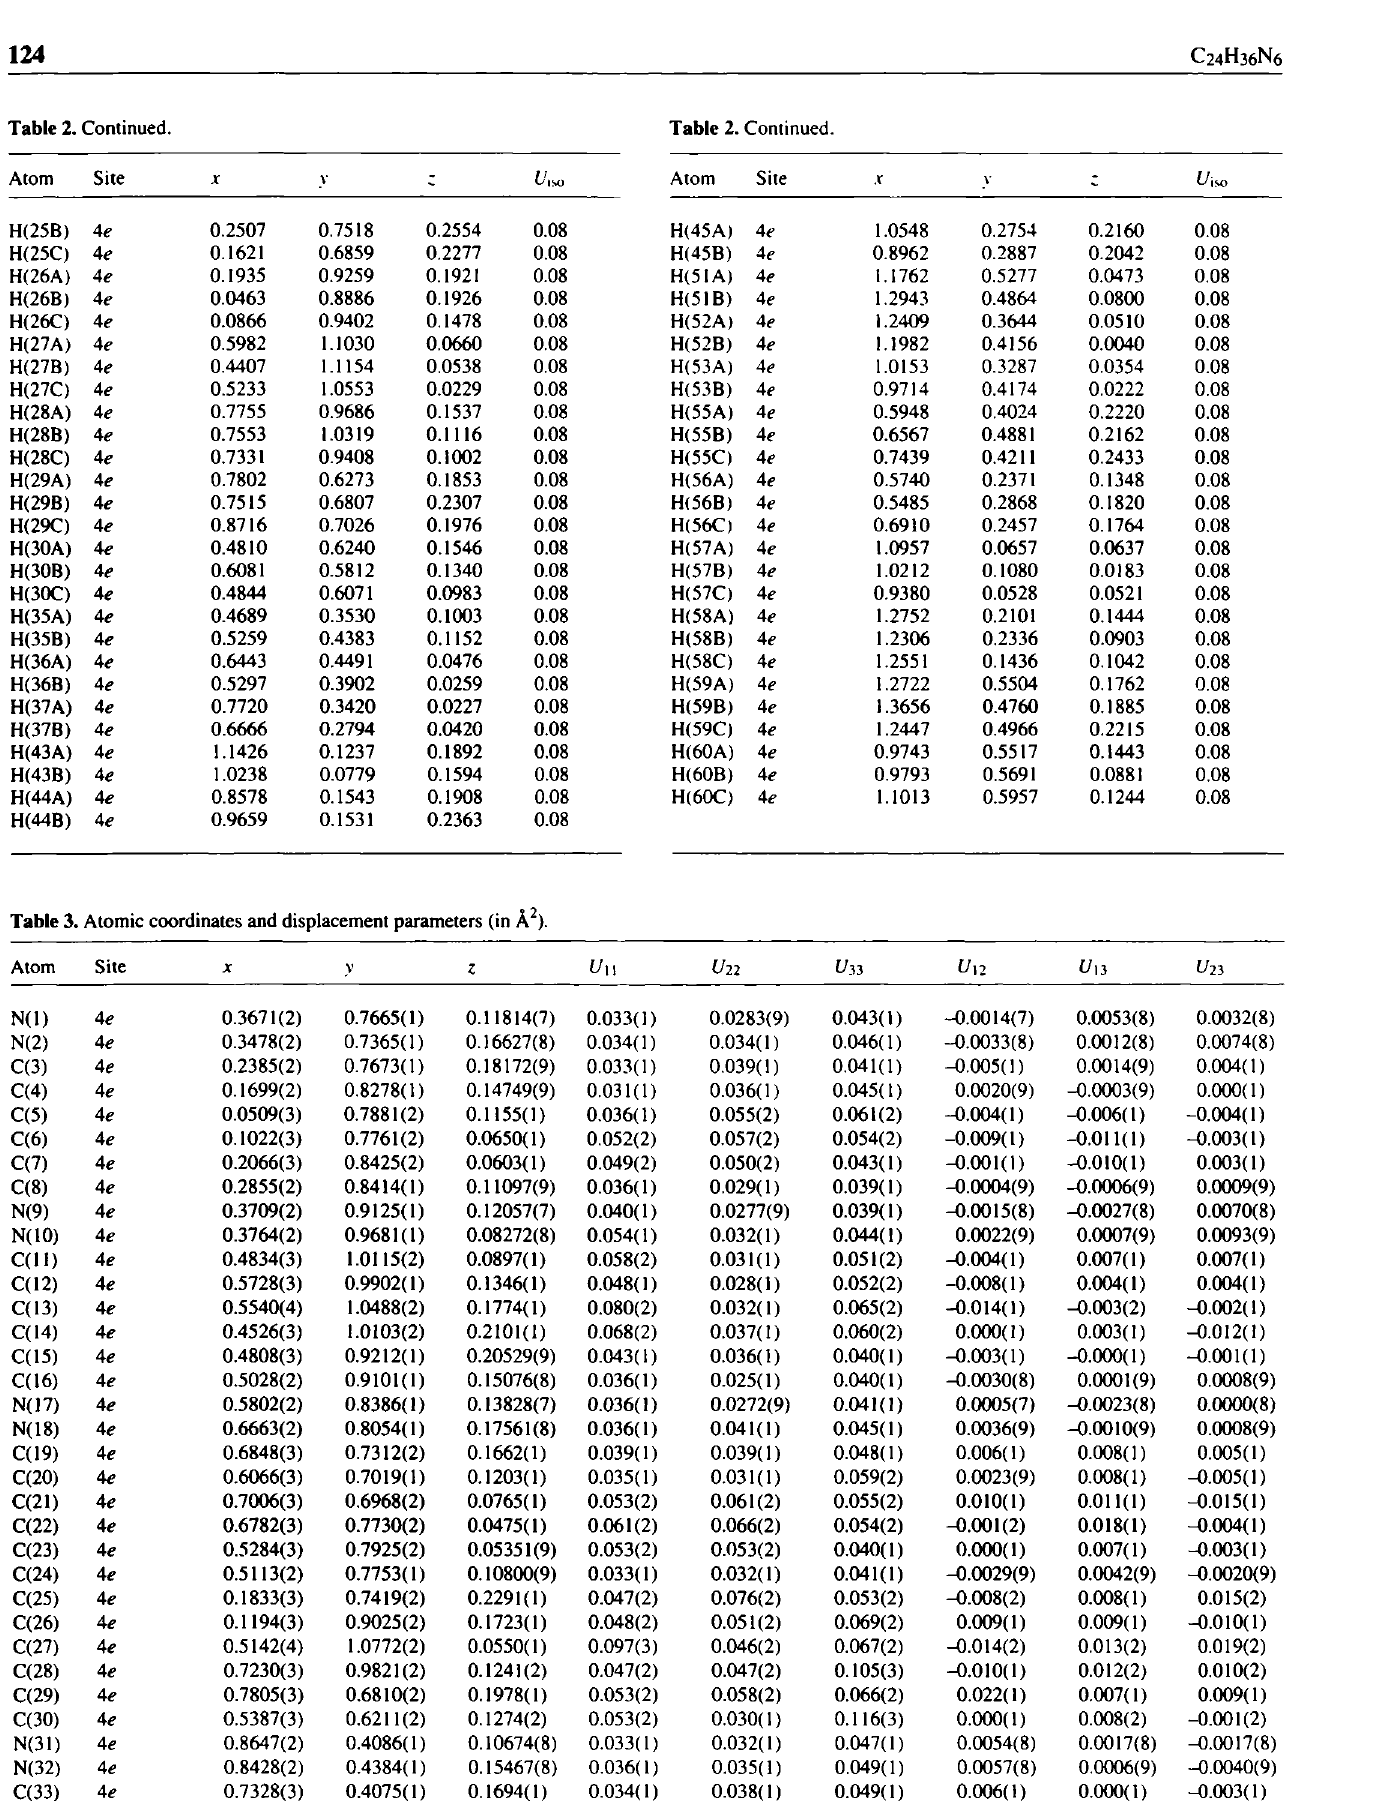
Table 3. Atomic coordinates and displacement parameters (in Ä 2